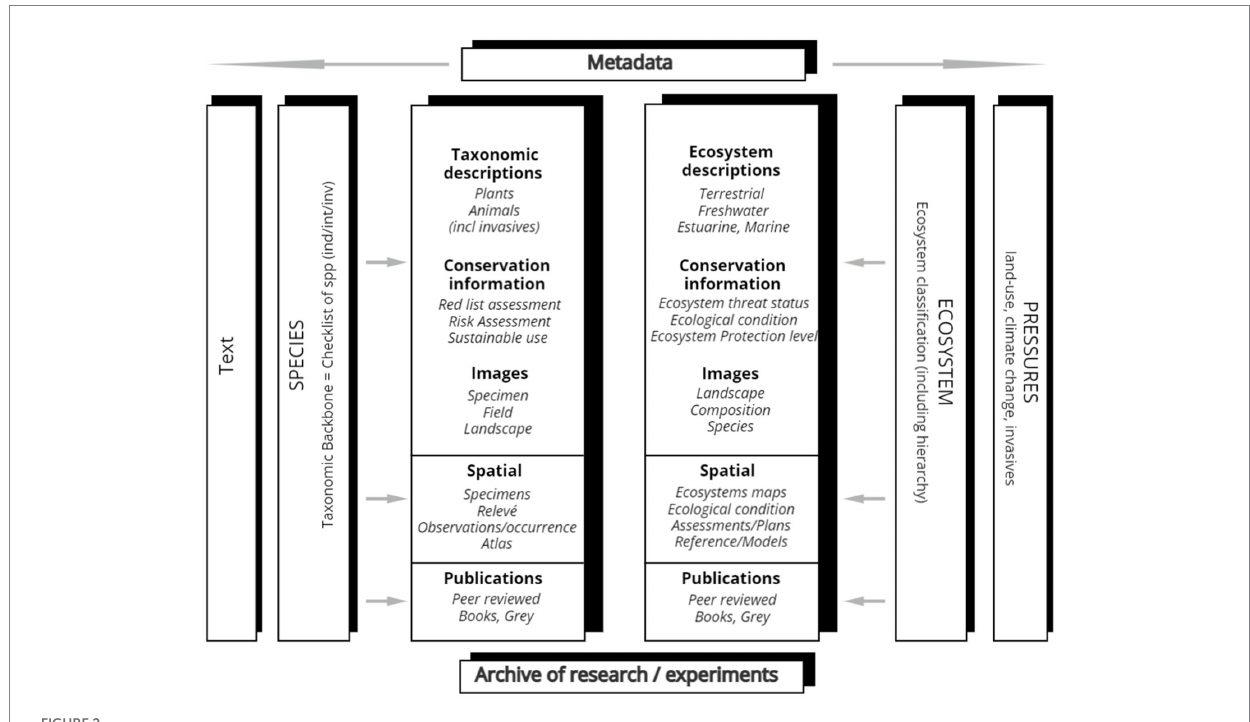
FIGURE 2 Diagram of an interoperable data